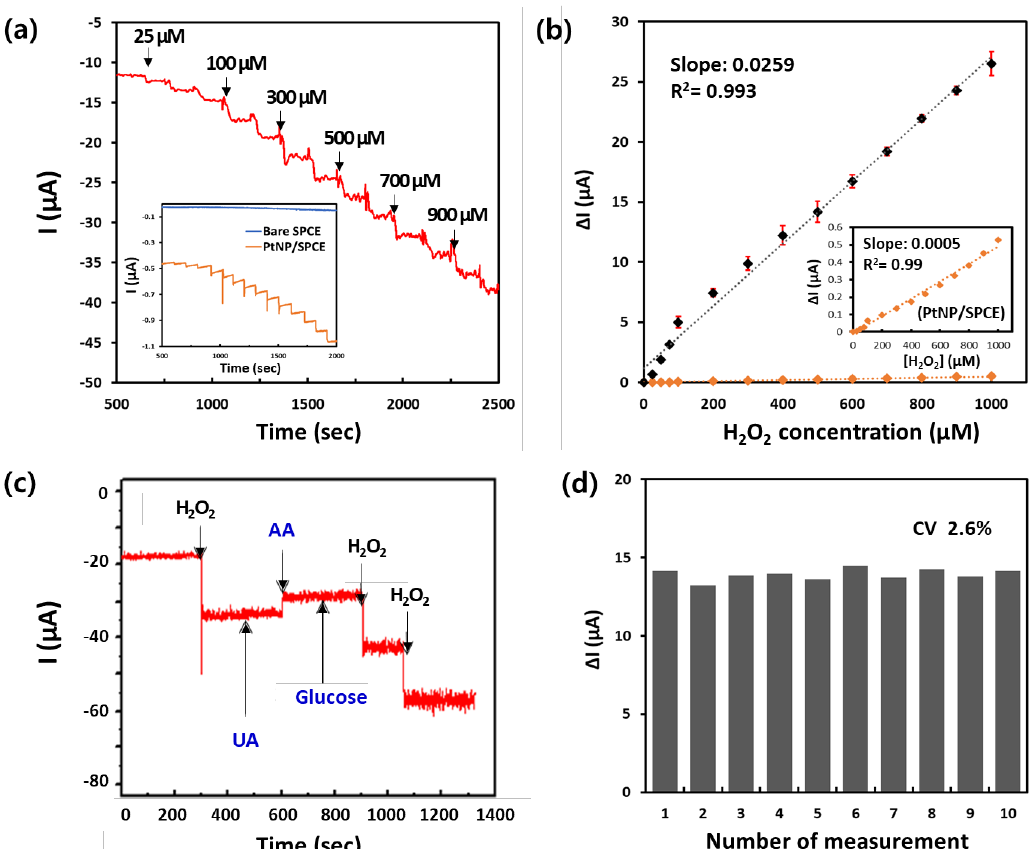
Figure 4. ( a ) Amperometric response of the PtNP/rGO–CNT/PtNP/SPCE with successive addition of H 2 O 2 in 0.1 M PBS containing 0.1 M KCl at −0.2 V (vs. Ag pseudo-reference electrode). Inset shows the amperometric responses of bare SPCE (blue line) and PtNP/SPCE (orange line) at the same conditions. ( b ) The corresponding calibration curve of the current change (ΔI) vs. the concentration of H 2 O 2 for the PtNP/rGO–CNT/PtNP/SPCE. Inset shows the resulting calibration curve for the PtNP/SPCE (orange line). ( c ) Current response of the PtNP/rGO–CNT/PtNP/SPCE with successive addition of 500 μ M H 2 O 2 and 1 mM AA, UA, and glucose in 0.1 M PBS containing 0.1 M KCl at −0.2 V (vs. Ag pseudo-reference electrode). ( d ) Reproducibility test result of PtNP/rGO–CNT/PtNP/SPCE electrodes with different fabrication dates, using a current response to 500 μ M H 2 O 2 in 0.1 M PBS containing 0.1 M KCl at −0.2 V (vs. Ag pseudo-reference electrode).